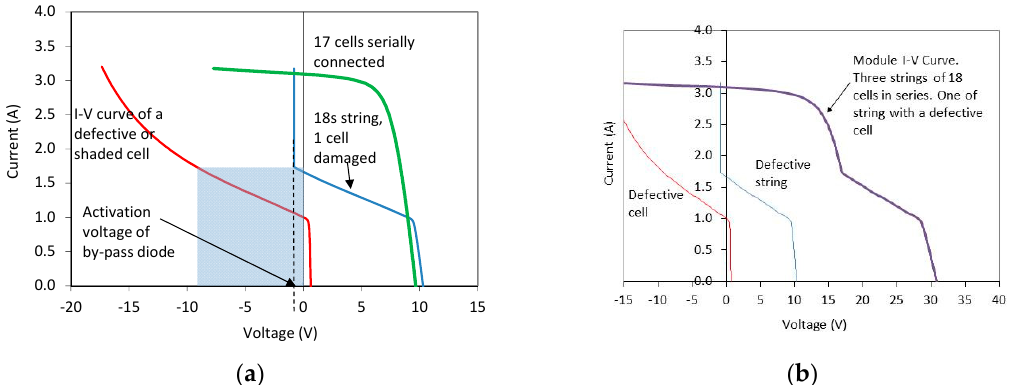
Figure 3. Working principle of the bypass diode. ( a ) Left: a damaged cell is associated in series with other 17 cells serially connected. The string has a bypass diode. The activation point of the bypass diode is shown. ( b ) Right: I-V curve of a PV module with three strings of 18 cells serially connected (18s). One of the strings has a defective cell.